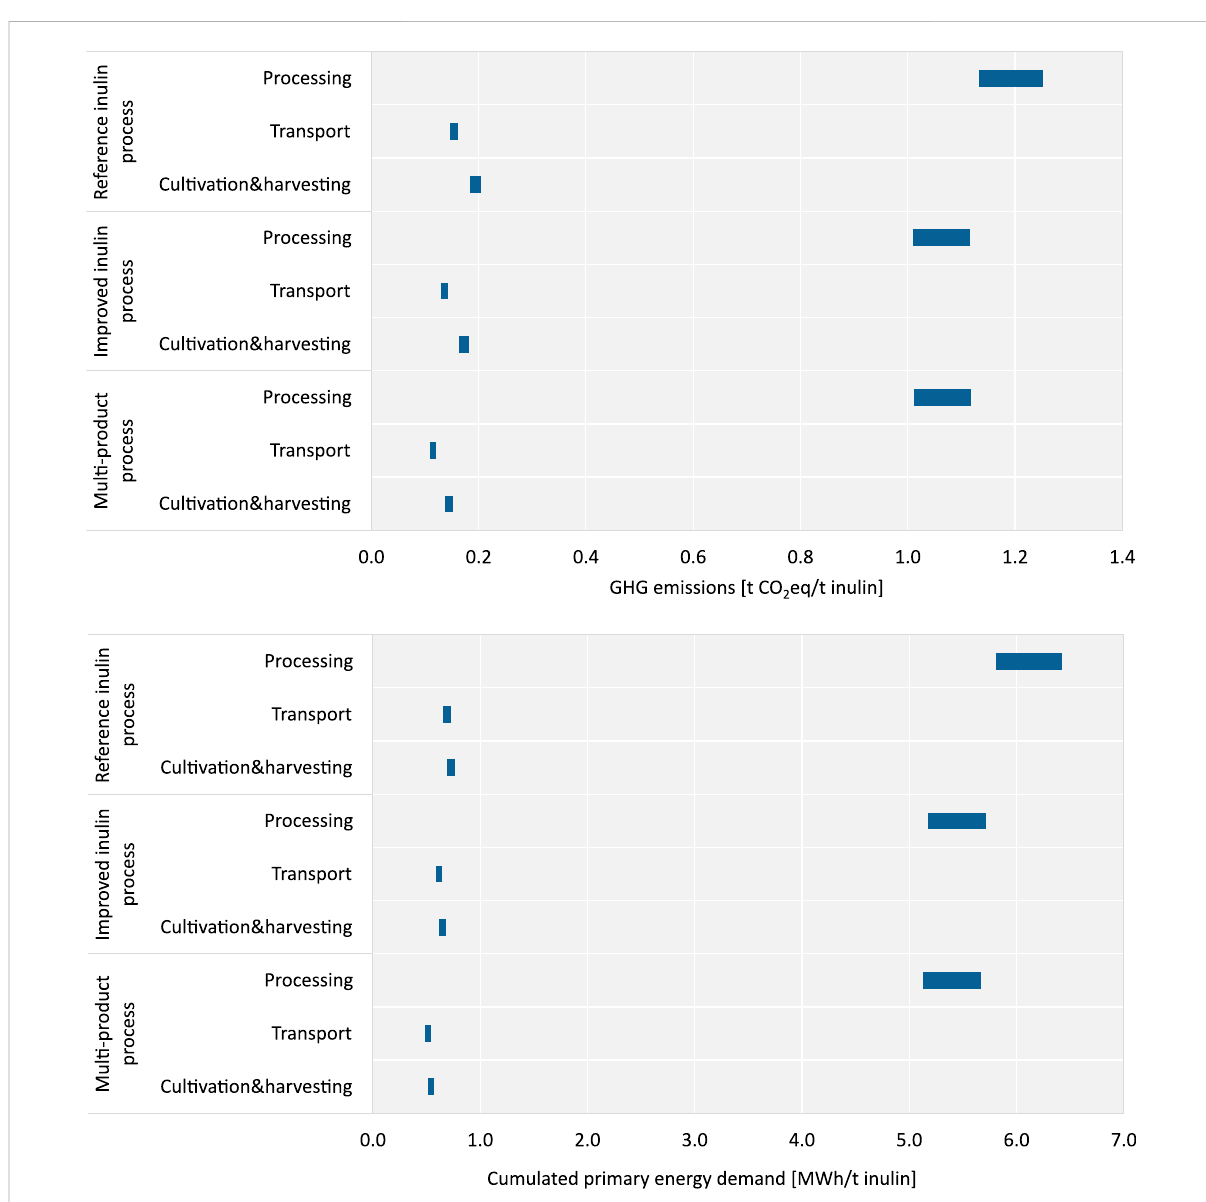
FIGURE 7 Contributions to the GHG emissions and cumulated primary energy demand by process steps (cultivation and harvesting, transport and processing).